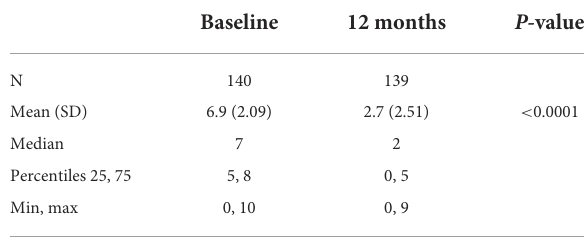
TABLE 12 Craving scores in Group 2 subjects who were administered more > 80 mg/day at any timepoint.